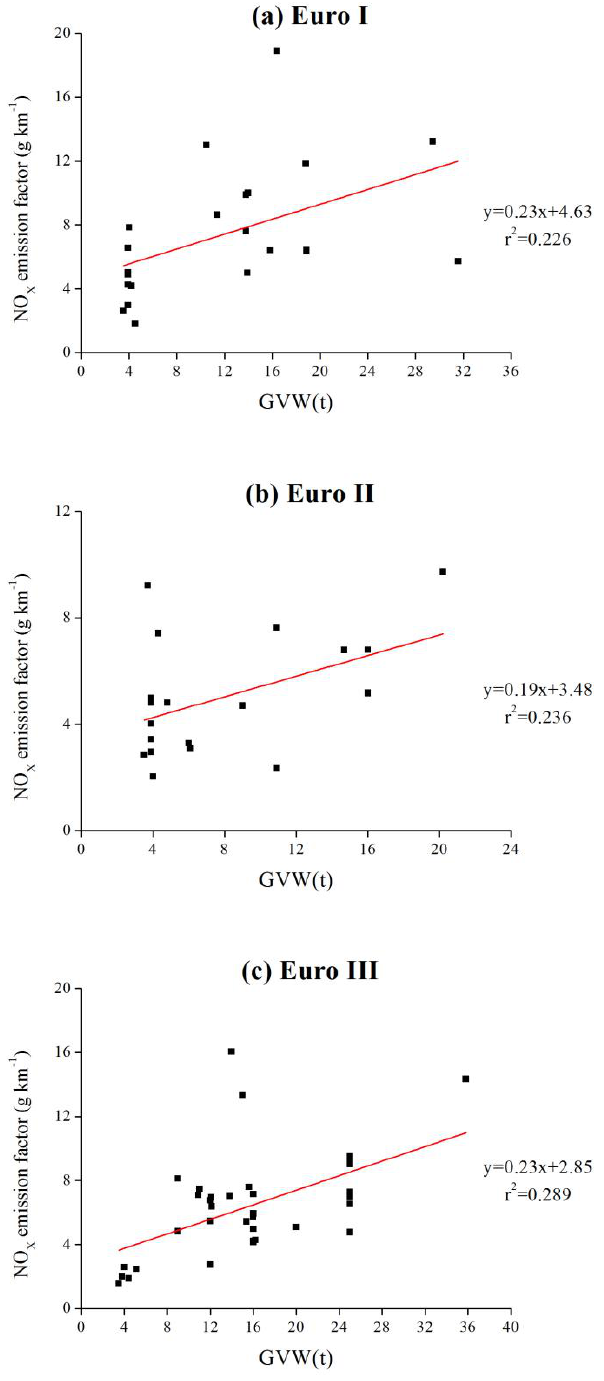
Fig. 5. The scatter graph of the relationship between vehicle weight and emission factor under the typical driving cycle for trucks with an average speed of 40 km h -1 , from Euro I to Euro III.